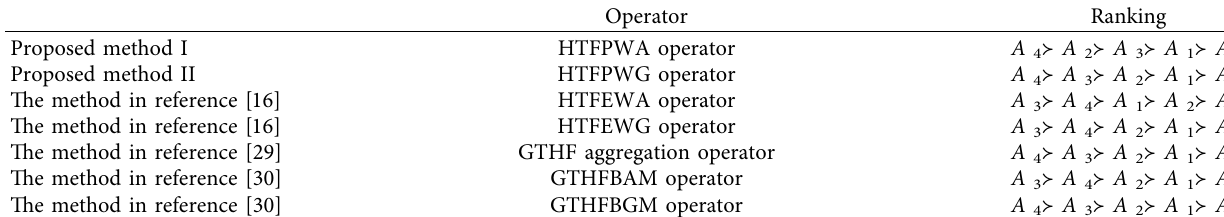
Table 2: Comparative analysis of operators.